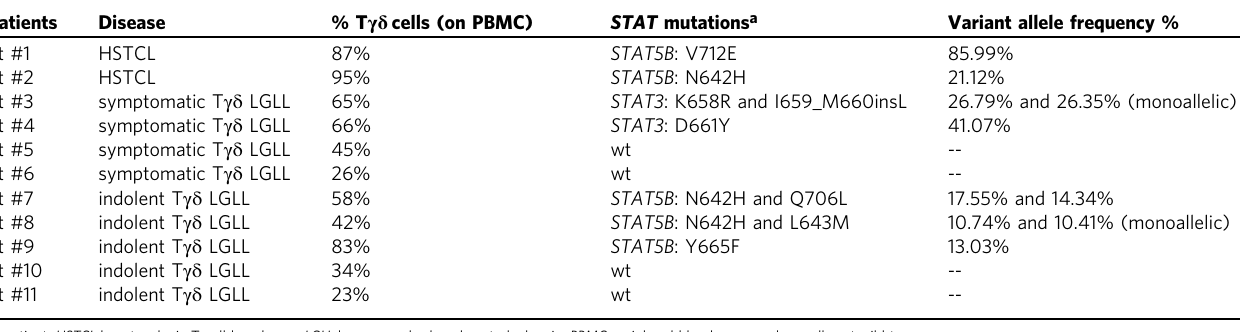
Table 3 Results about T γδ clonal expansions collected by fl ow cytometry and NGS STAT mutations screening. Patients